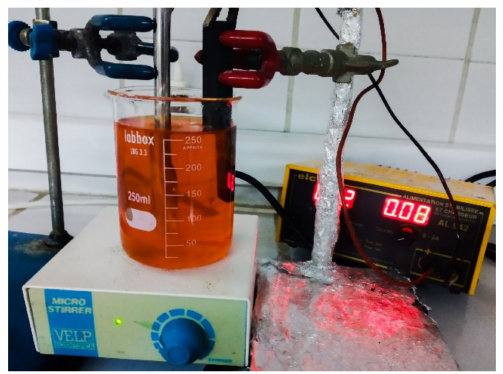
Figure 8. Experimental instrument used in the Electro-Fenton